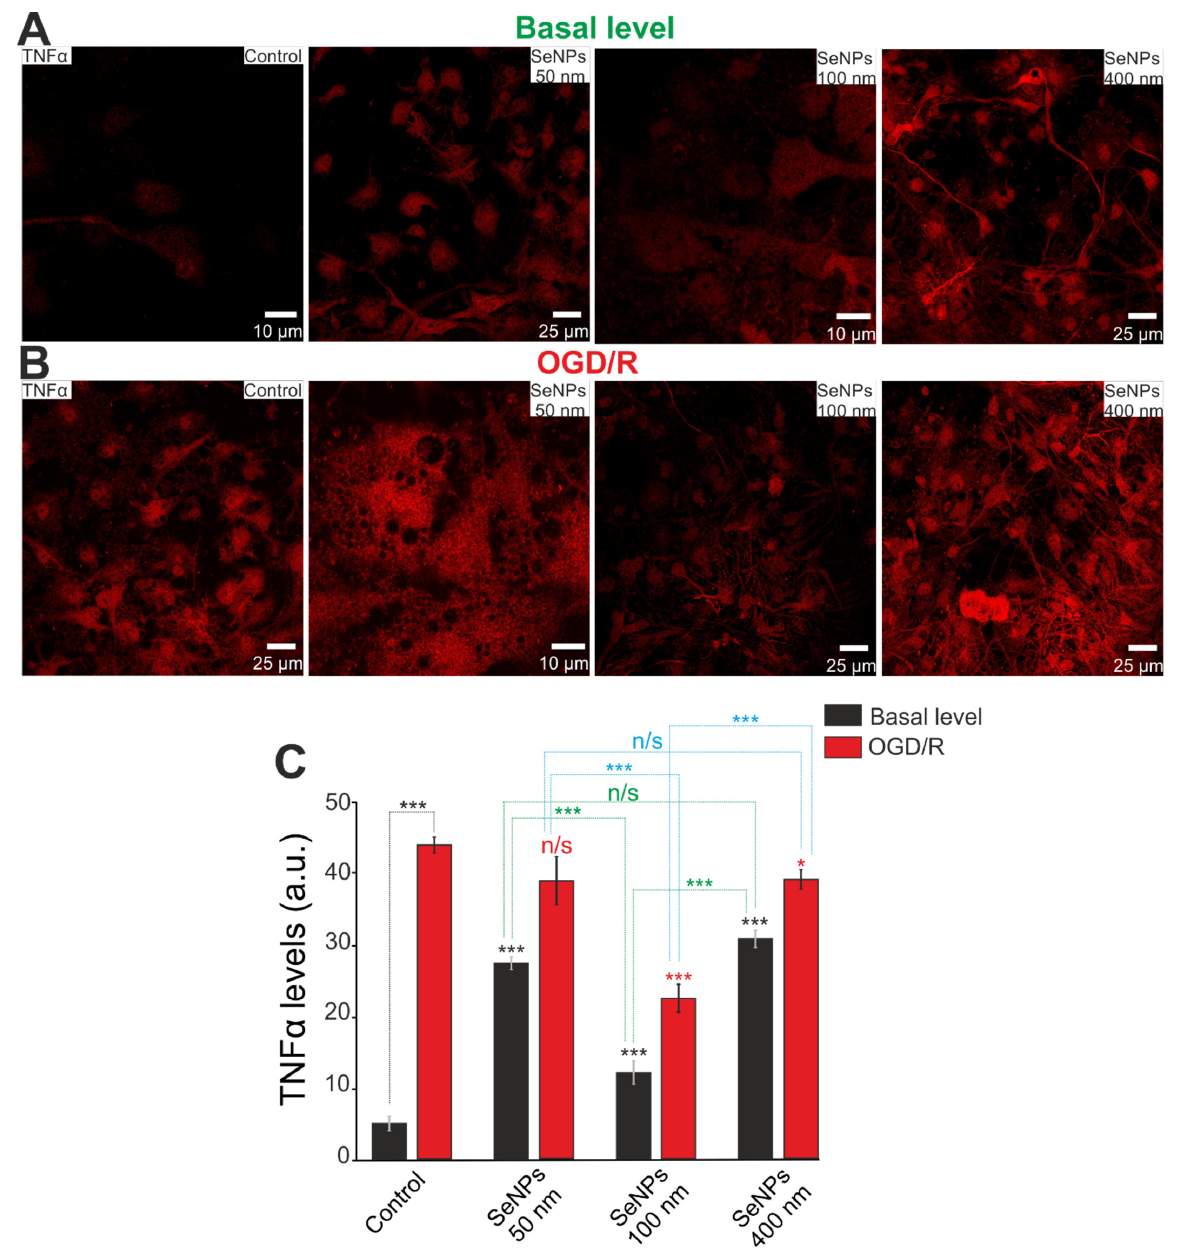
Figure 9. Immunocytochemical staining of cortical cell culture with antibodies against TNF α , a multifunctional pro-inflammatory cytokine, after 24-h incubation with 3 μ g/mL of different-sized SeNPs without OGD/R ( A ) and 24 h after OGD/R ( B ). ( C )—Intensity levels of TNF α were determined by confocal imaging. We analyzed individual cells that had fluorescence of secondary antibodies. The quantative data reflecting the level of TNF α expression are presented as fluorescence intensity values in summary bar charts (mean ± SEM). The values were averaged by 100–150 cells for each column. The results obtained after immunostaining agree with the data of fluorescence presented in panels ( A , B ). Each value is the mean ± SE ( n ≥ 3, p < 0.05). Statistical significance was assessed using paired t -test. Black asterisks represent comparison of baseline expression levels after incubation with different sized nanoparticles versus control. Red asterisks represent comparison of expression level after incubation with different-sized SeNPs versus OGD/R-induced levels; n/s—data not significant ( p > 0.05), * p < 0.05 and *** p < 0.001.